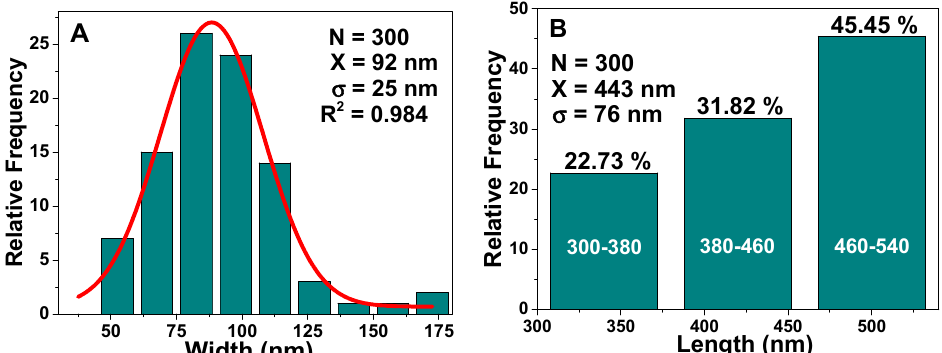
Figure 7. ( A ) Width and ( B ) length distributions of the S15N mesoporous silica nanorods. ( A ) N is the sampling, X and σ are the center and width of the Gaussian distribution, while for ( B ), X and σ are obtained from the arithmetic mean.